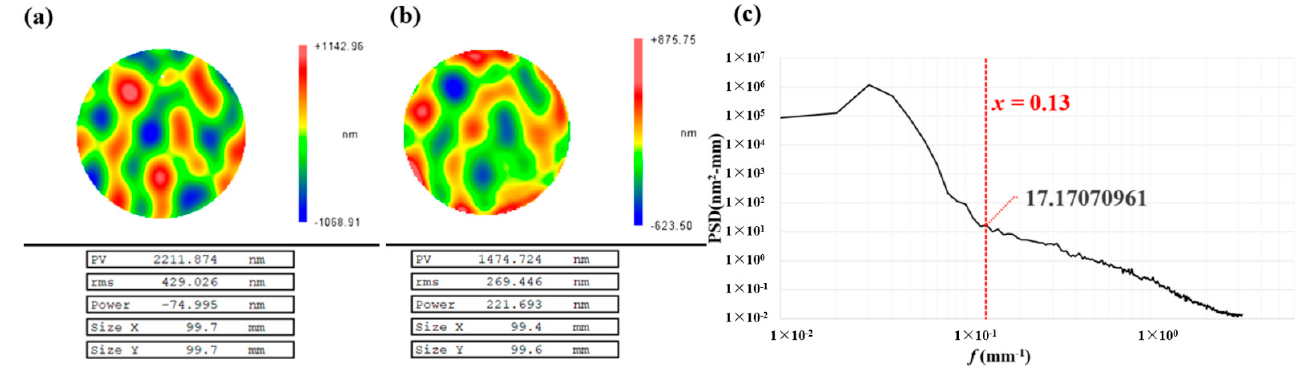
Figure 2. ( a ) Design surface. ( b ) Matching residual after MRF. ( c ) PSD curve of the design